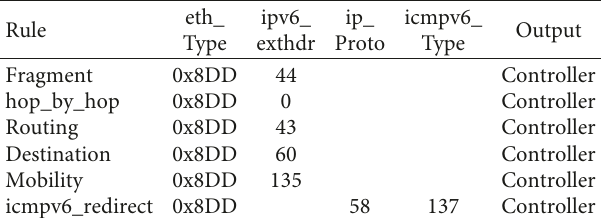
Table 5: Static rules against firewall